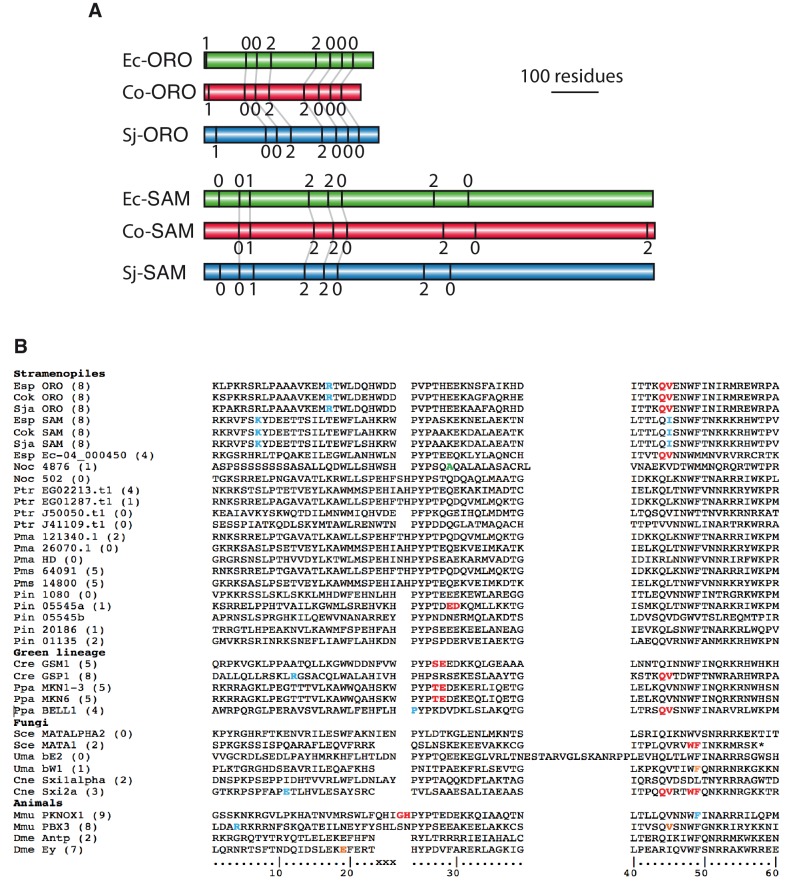
Intron conservation in homeobox genes.(A) Conservation of introns in Ectocarpus (Ec), C. okamuranus (Co) and S. japonica (Sj) ORO and SAM genes. Schematic representation of the coding regions of ORO and SAM genes showing the positions and phase of introns. Conserved intron positions, based on sequence similarity, are indicated by grey lines. Intron boundaries at similar positions but not linked by a grey line are also likely to be ancestral but it is not possible to verify homology because these regions of the proteins are too diverged. Protein identifiers are Ec-ORO, Ec-14_005920; Co-ORO, Cok_S_s017_4976 .t2; Sj-ORO, SJ07622; Ec-SAM, Ec-27_006660; Co-SAM, Cok_S_s018_5094mod; Sj-SAM, SJ10977mod where the suffix ‘mod’ indicates that the original gene model has been modified (see Supplementary file 6). (B) Positions of homeobox introns in stramenopile homeobox genes, life cycle regulators from the green lineage, fungal mating type regulators and selected metazoan homeobox genes. Intron positions are colour coded according to phase: 0, red; 1, blue; 2, orange. The numbering at the bottom indicate the conserved 60 residues of the homeodomain and xxx indicates the three additional amino acids in TALE HD TFs. Numbers in brackets indicate the number of introns in the entire coding region of each gene. The asterisk indicates a stop codon. Esp, Ectocarpus sp.; Cok, Cladosiphon okamuranus; Sja, Saccharina japonica; Noc, Nannochloropsis oceanica; Ptr, Phaeodactylum tricornutum; Pmu, Pseudo-nitzschia multiseries; Cre, Chlamydomonas reinhardtii; Ppa, Physcomitrella patens; Sce, Saccharomyces cerevisiae; Uma, Ustilago maydis; Cne, Cryptococcus neoformans; Dme, Drosophila melanogaster. Note that Phytophthora infestans gene 05545 has two homeoboxes. Supplementary files.